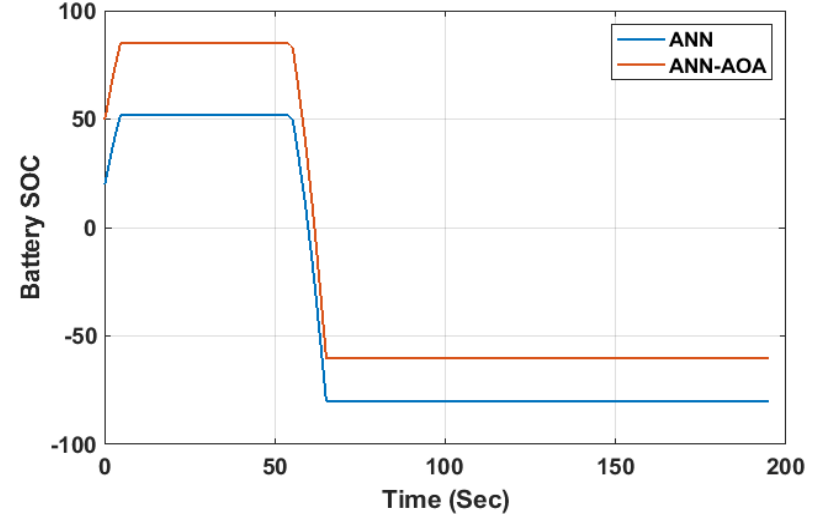
Figure 12. Analysis of SOC of a battery with and without ANN–AOA.